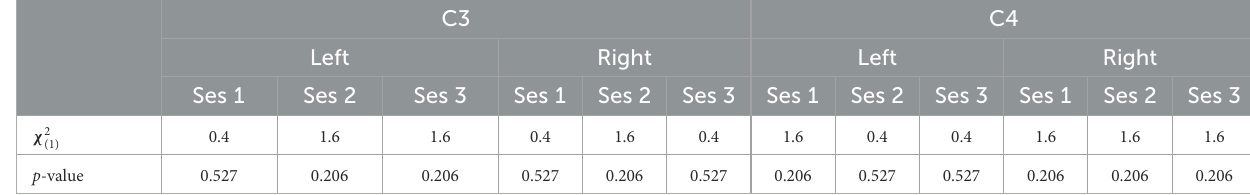
TABLE 2 The χ 2 score and the p -values obtained through the Friedman test comparing the two different perspective conditions. C3 C4 Left Right Left Right Ses 1 Ses 2 Ses 3 Ses 1 Ses 2 Ses 3 Ses 1 Ses 2 Ses 3 Ses 1 Ses 2 Ses 3 χ 2 (1) 0.4 1.6 1.6 0.4